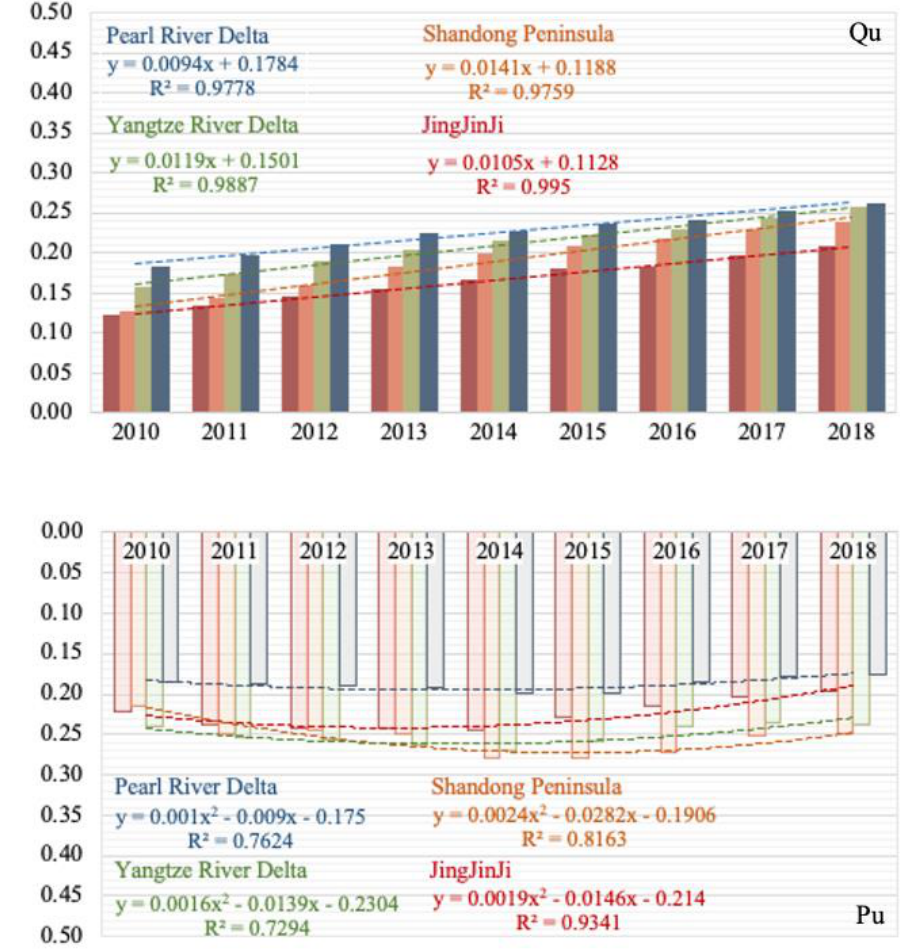
Figure 8. Data comparative analysis of Qu and Pu among four megalopolises. Table 3. Data comparative analysis among four megalopolises.